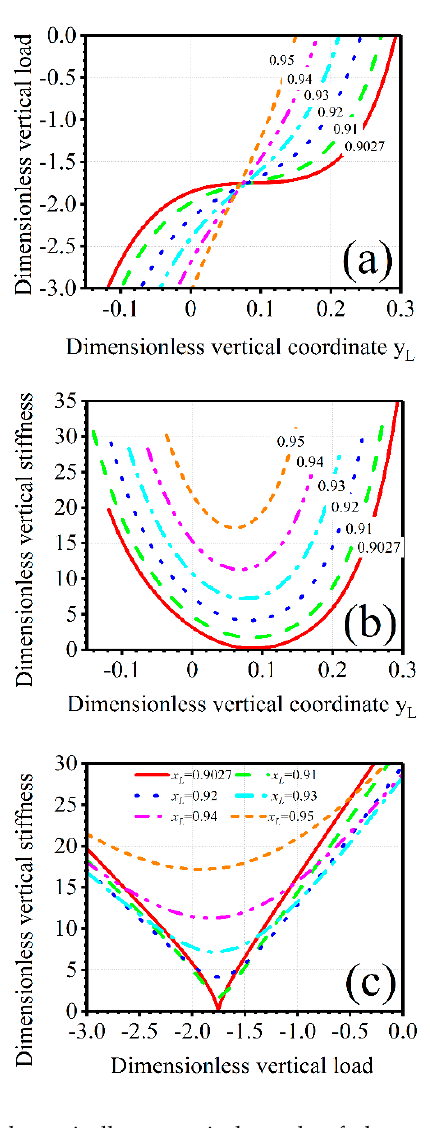
Figure 3. Dimensionless theoretically numerical result of the geometric anti-spring isolator. ( a ) Dimensionless vertical force. ( b ) Dimensionless vertical stiffness vs. vertical coordinate. ( c ) Dimensionless vertical stiffness vs. vertical force.